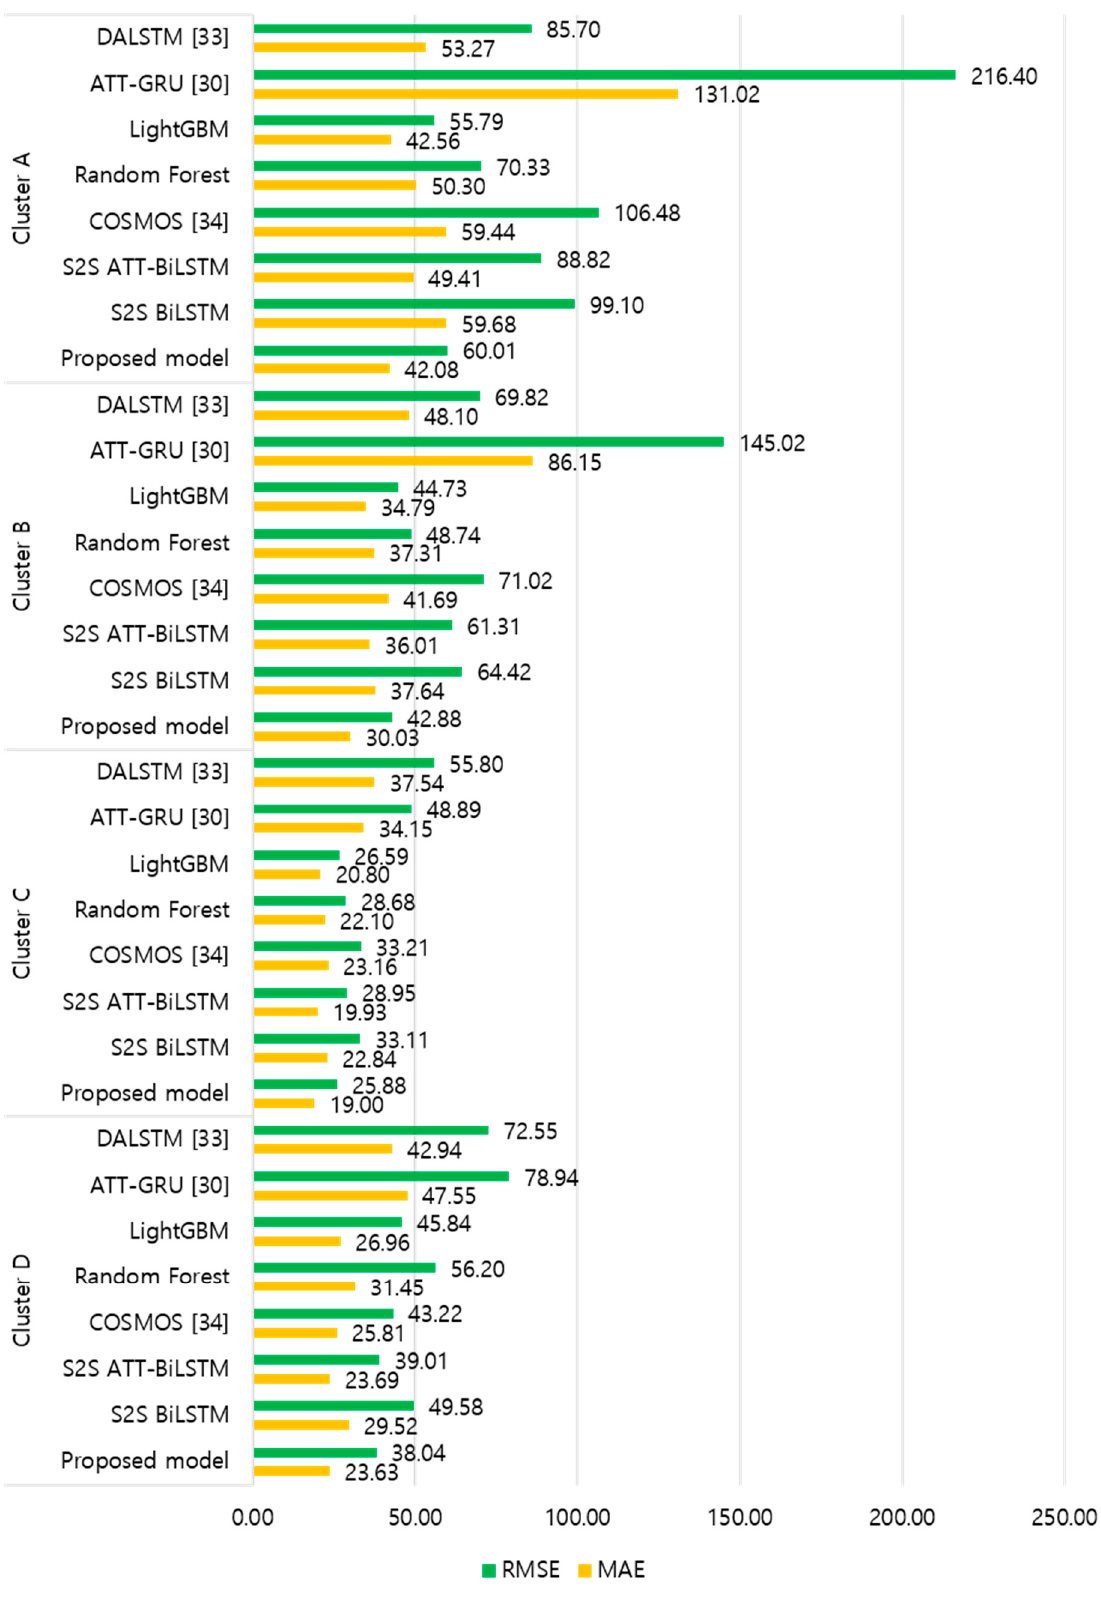
Figure 10. Average of RMSE and MAE for each model (kWh).